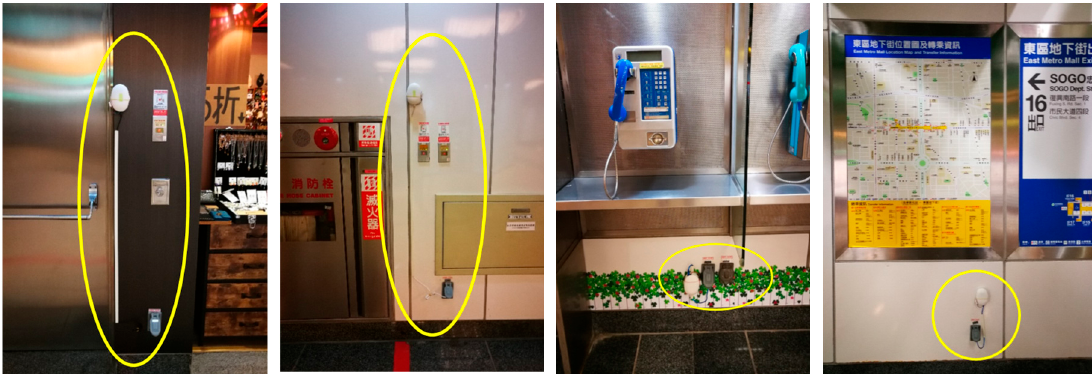
Figure 21. Photos of the deployed devices.